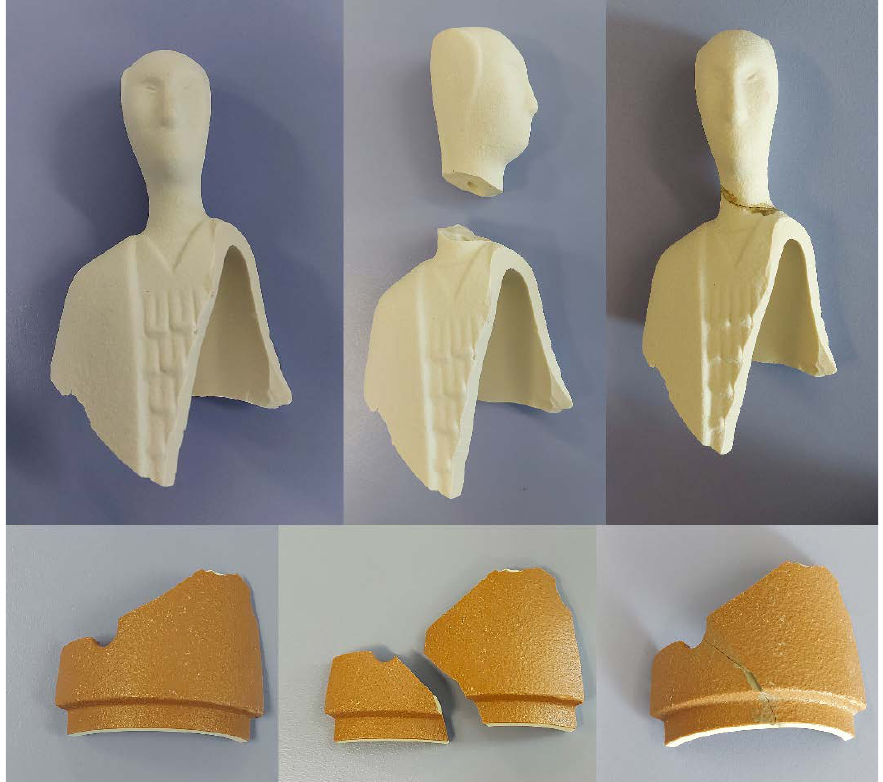
Figure 5. Porcelain stoneware and pottery artworks restored and repaired by using the geopolymer- based materials PS-MK and RP dry -MK described in this paper.